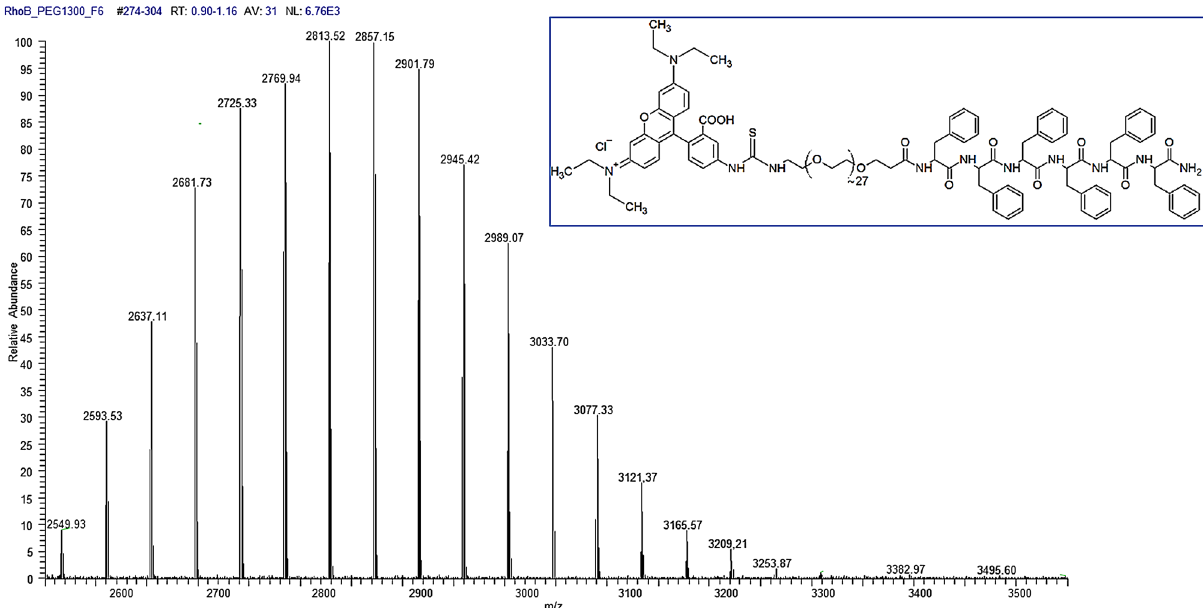
Figure 1. ESI mass spectrum of the Rho-PRG1300-F6 peptide derivative. Inset—schematic representation of Rho-PRG1300-F6